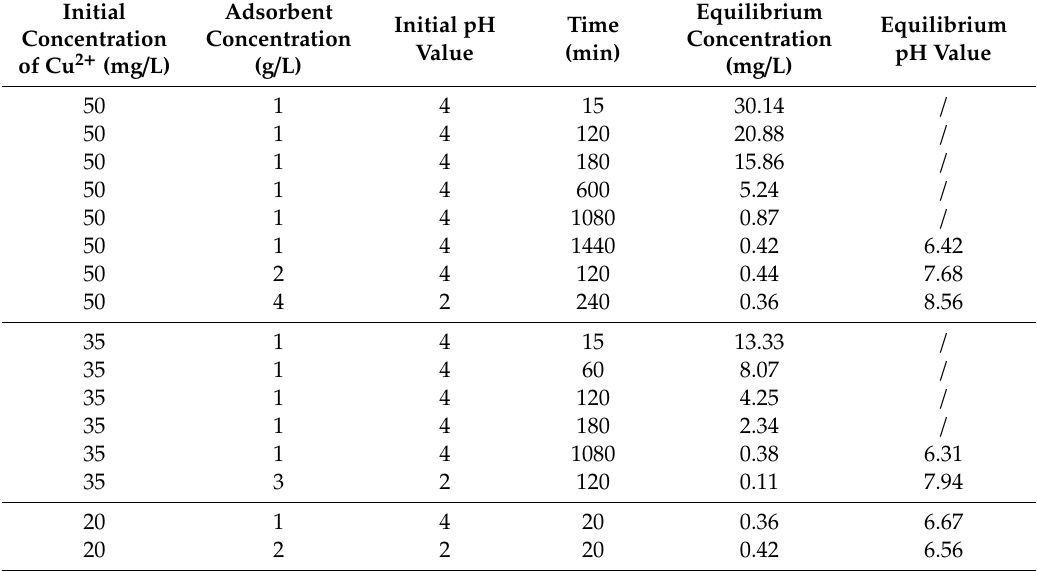
Table 4. The adsorption results of CFAMH for Cu 2 + .